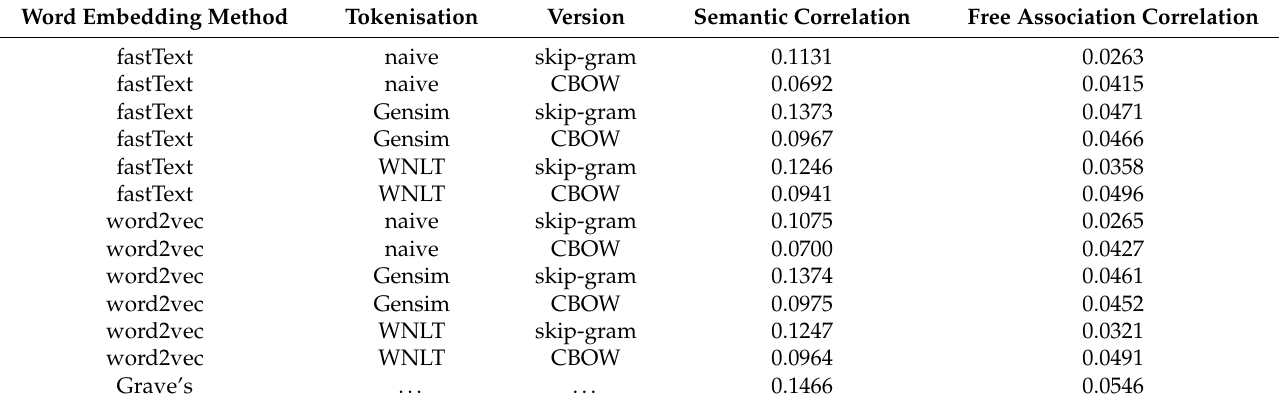
Table 3. The results achieved on the SimLex-999